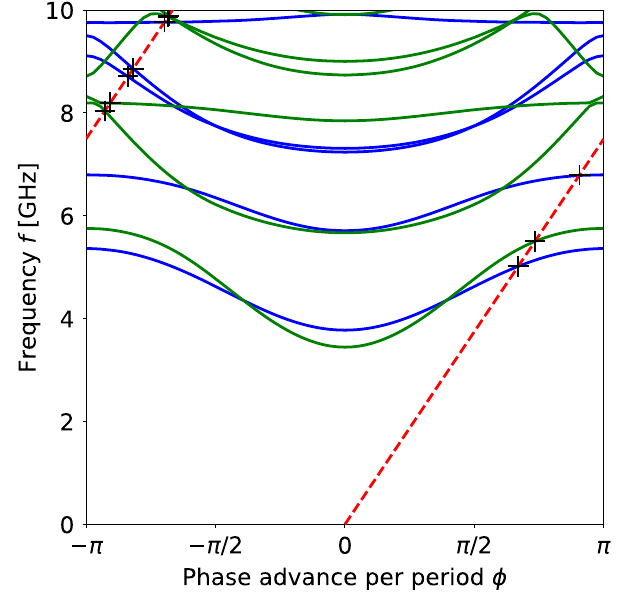
FIG. 4. Dispersion diagram for the bellows structure depicted in Fig. 3. The blue lines correspond to longitudinal modes, and the green lines correspond to transverse modes. The synchronous points are marked with black crosses.